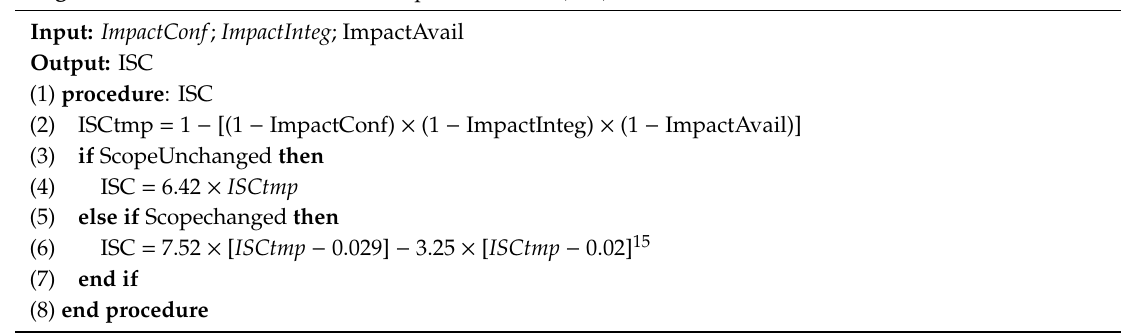
Algorithm 2. Calculate the value of impact sub score